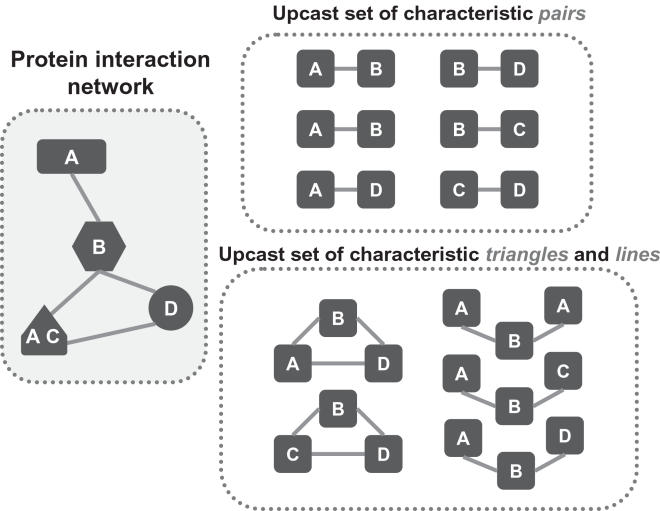
Upcast Sets of Characteristic Pairs and Triplets.In this example, we consider only a single characteristic (e.g., protein function), so that the characteristic vector for a protein is a 1-vector. There are three single-category proteins and one two-category protein in the protein interaction network (left), which result in an upcast set of six characteristic pairs {A–B, A–B, A–D, B–D, B–C, C–D}. Alternatively, the upcast set of triplets includes two triangles and three lines.